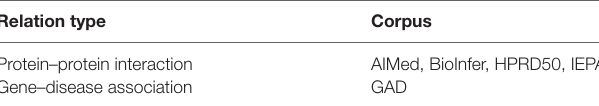
TaBle 4 | Concordance rate between PKDE4J and SemRep. TaBle 5 | Five corpora for evaluation of relation extraction